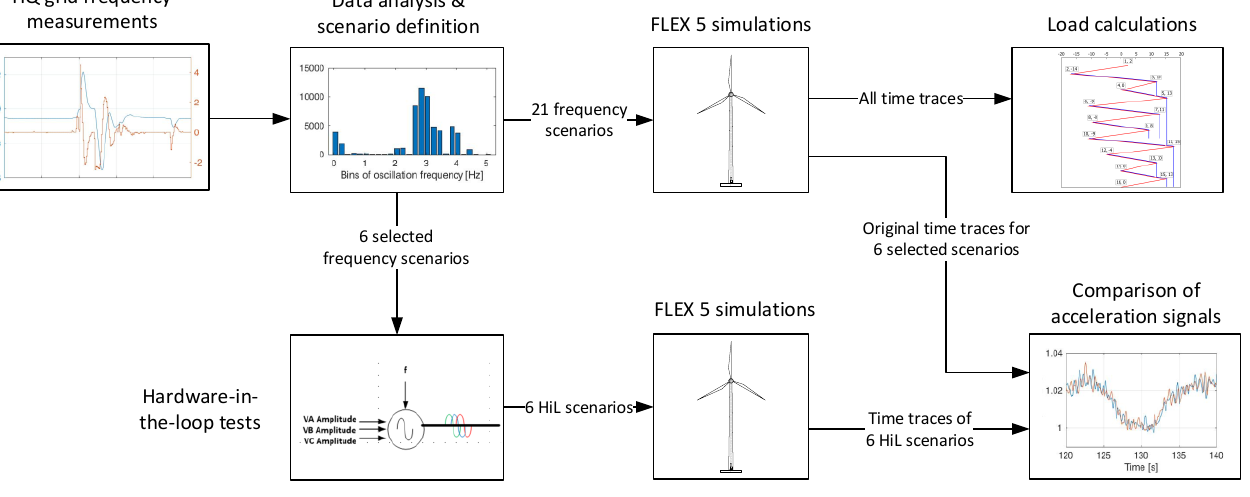
Figure 1. Overview of the used methodology .